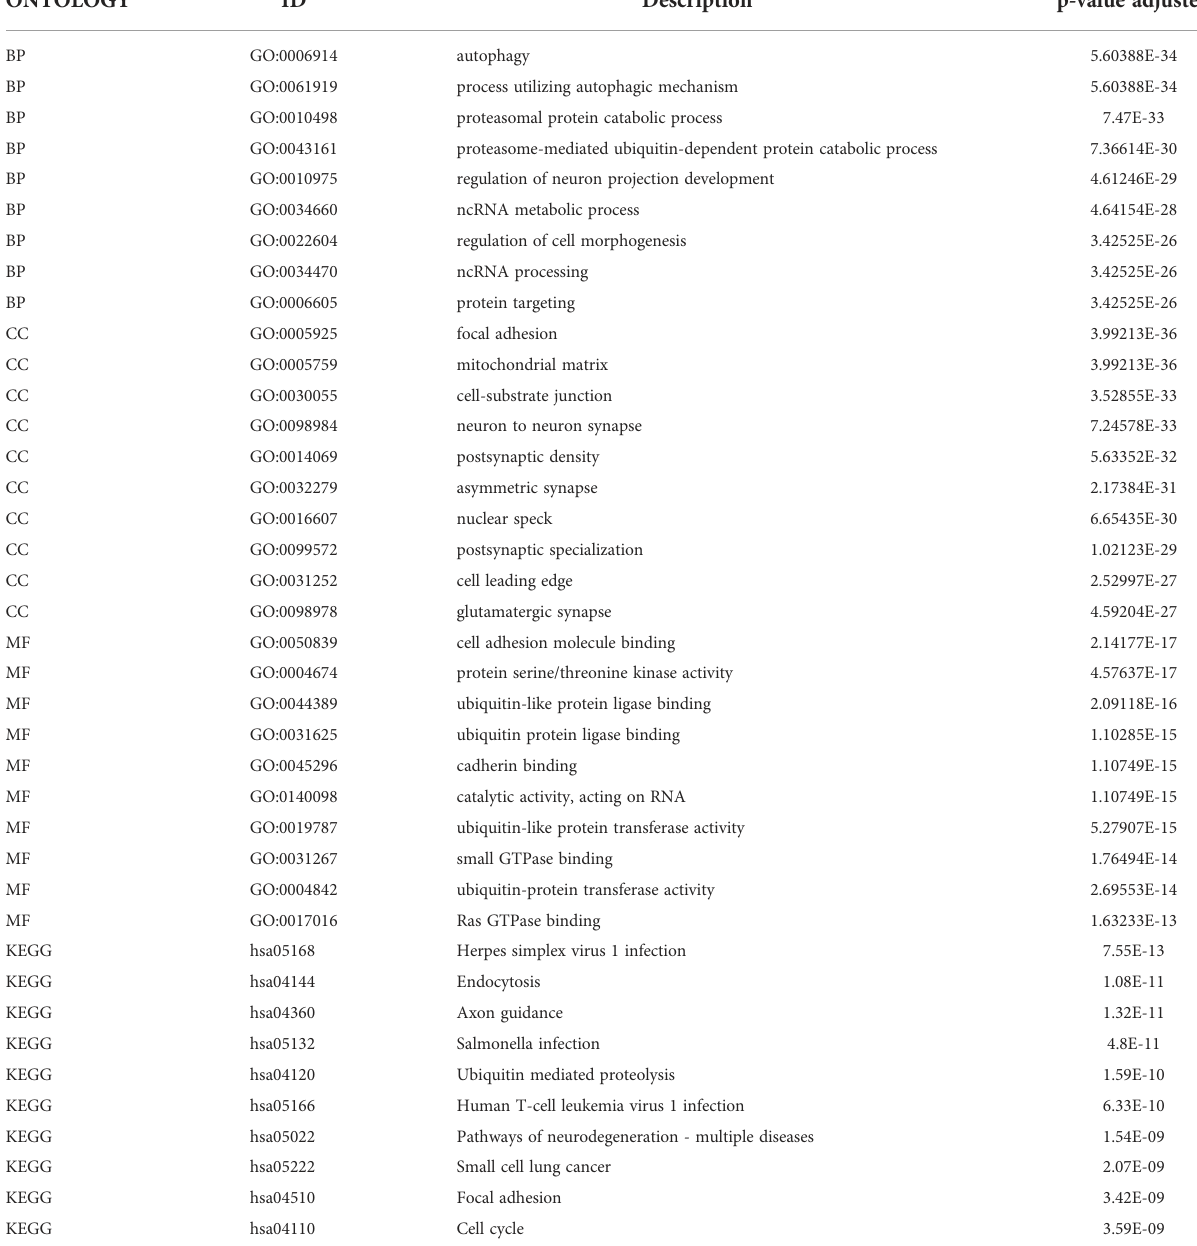
TABLE 3 Enrichment analysis of DEGs between TRAF3IP3-high expression group and TRAF3IP3-low expression group.